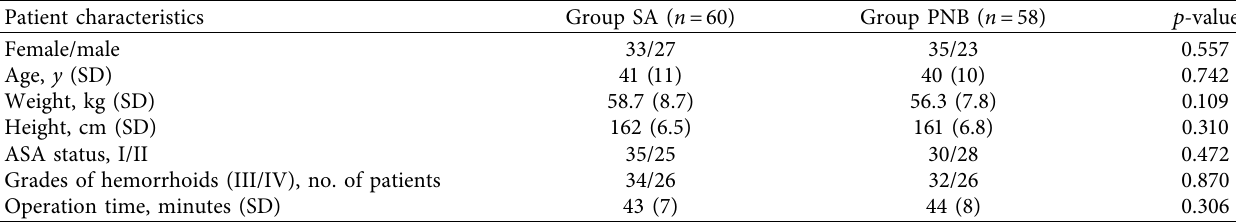
Figure 2: Consolidated standards of reporting trials flow Table 1: Demographic data and duration of surgery.